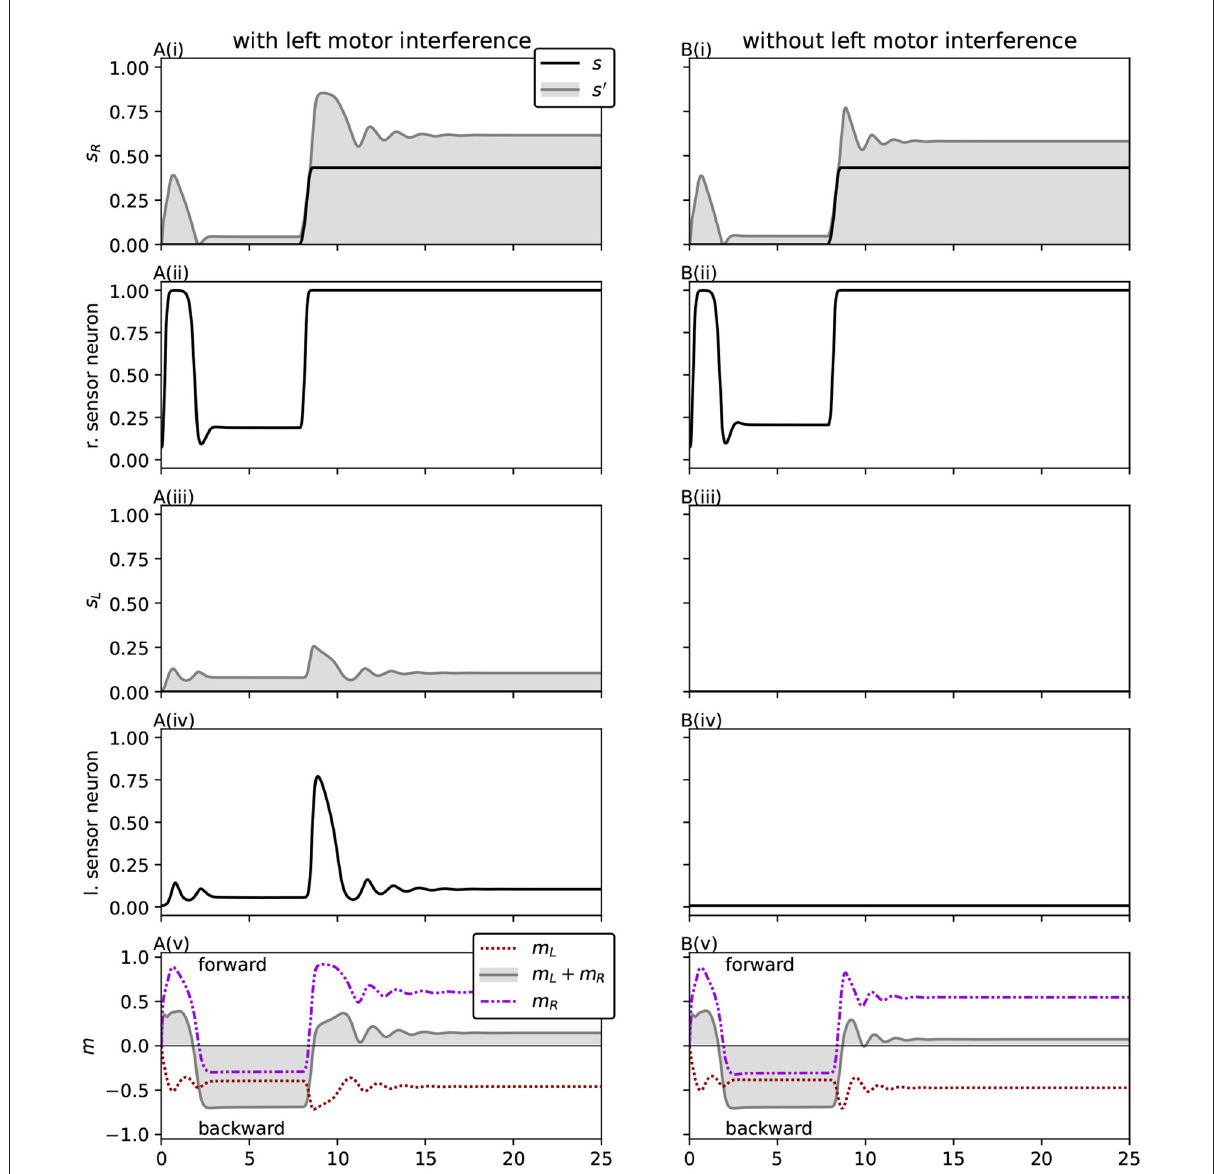
FIGURE11 The magnitude and duration of the initial motor response to sensor stimuli are strengthened by the presence of left motor interference. Sensorimotor activity and sensory neuron output time series are shown for the solution evolved with squared interference (Equation 13), when the right sensor is presented with an artificial environmental stimulus, which spikes and plateaus around t condition of evolutionary adaptation for the robot, with motor interference present. (B) Shows the response when the left motor-sensor interference is removed. The duration and intensity of the motor response to the stimulus is diminished without the interference, indicating that the interference plays a functional role in the evolved behavior. Additionally, it can be seen that the response to sudden right sensor stimulation is accompanied by internal negative feedback—even when the stimulation persists, motor activity quickly falls from the initial peak.